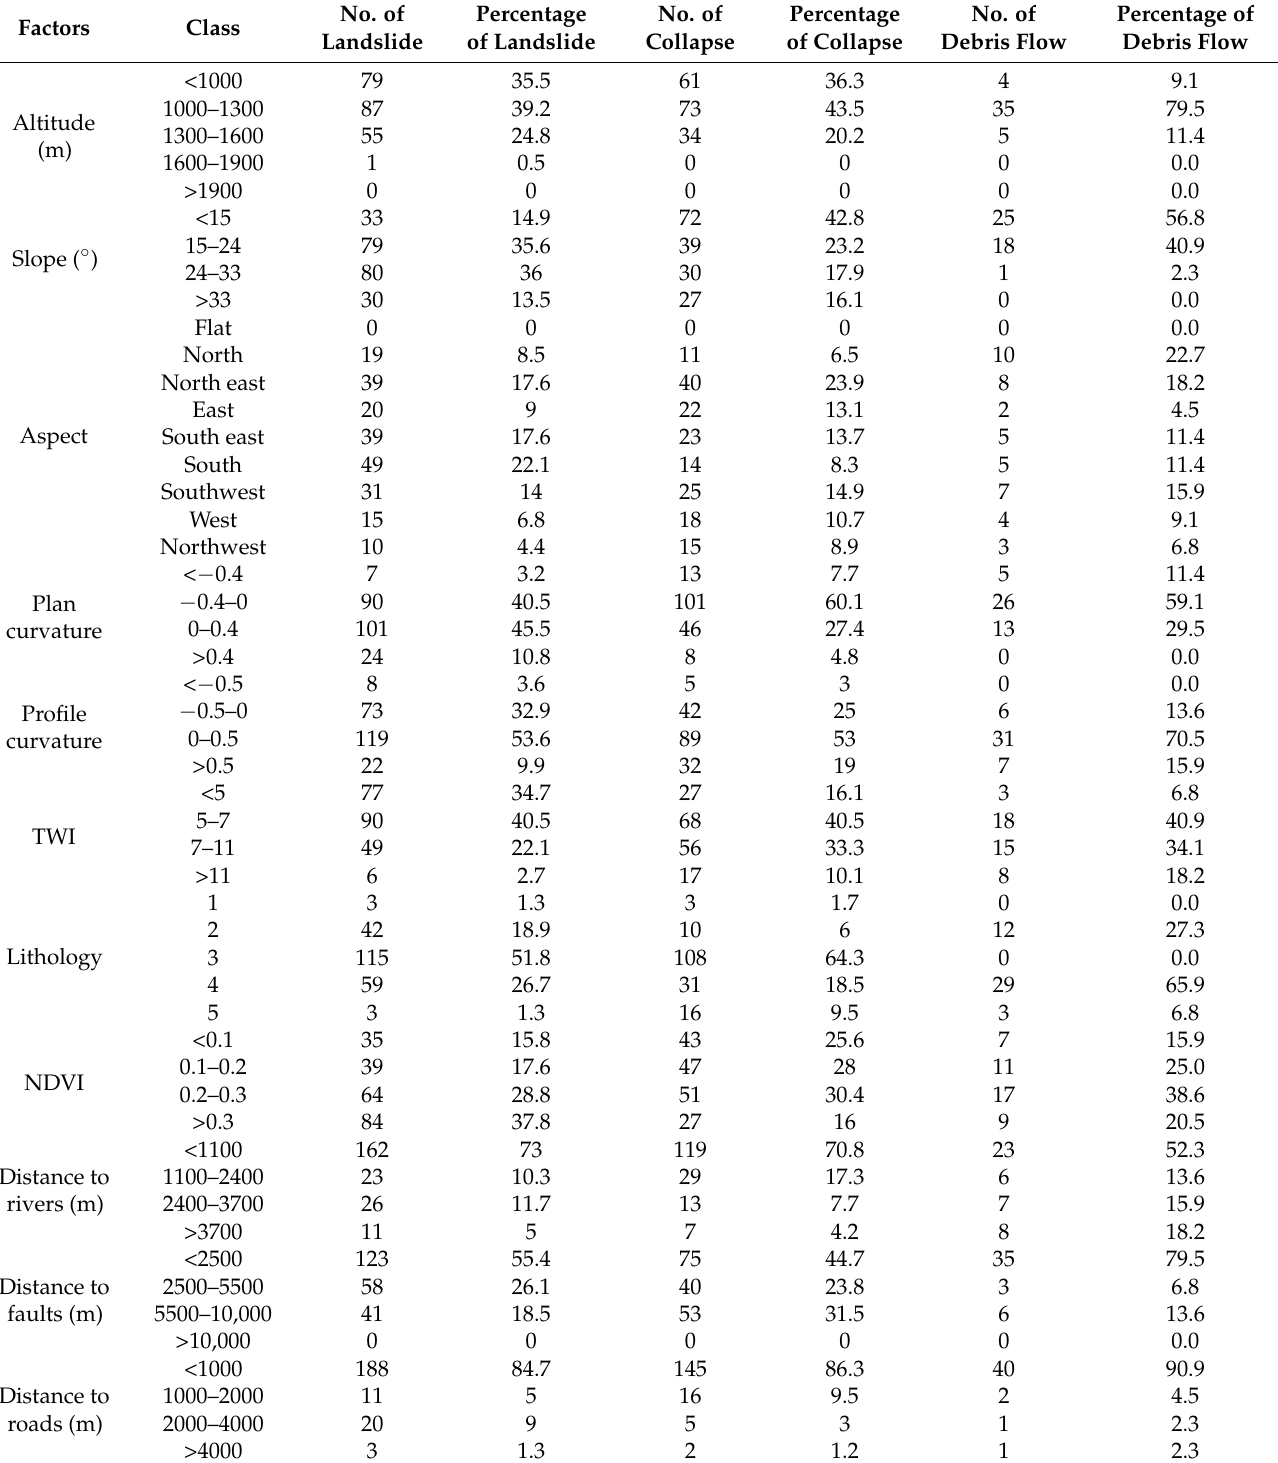
Table 8. Spatial relationship between each conditioning factor and